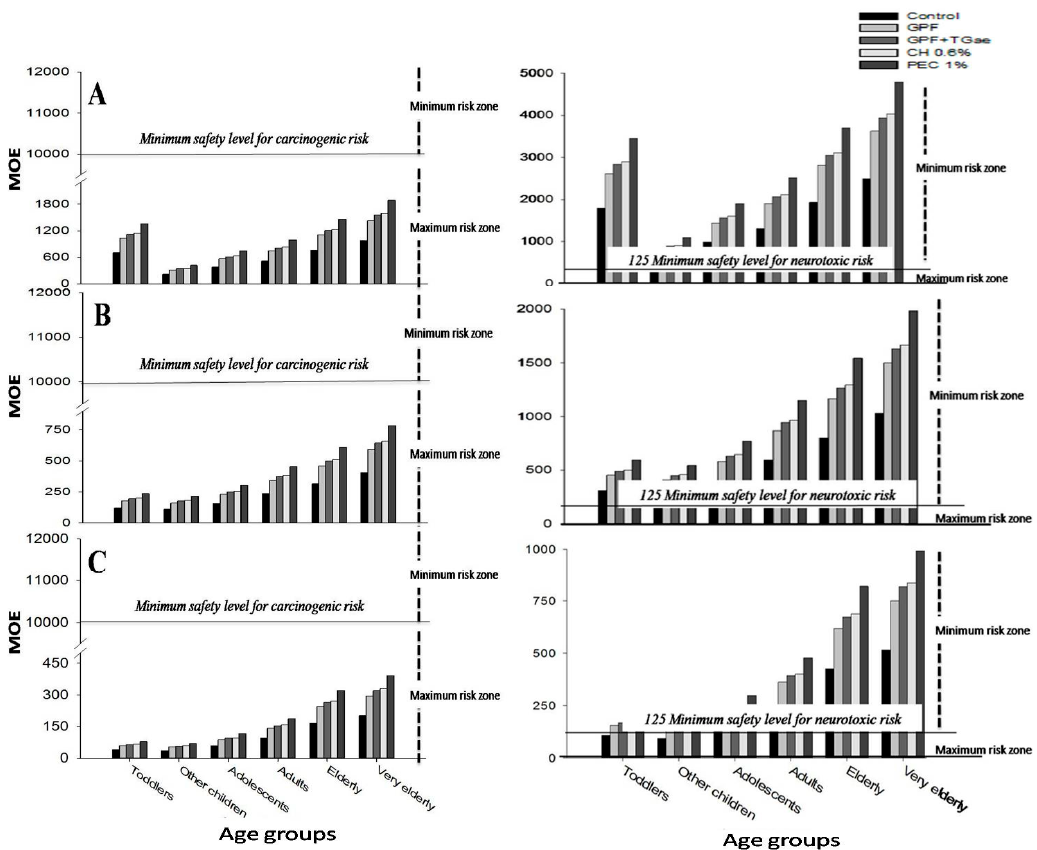
Figure 2. Margin of exposure (MOE) values for carcinogenicity (left panel) and neurotoxic (right panel) of acrylamide through the consumption of French fries that were both uncoated and coated with hydrocolloid coating solutions. Samples were coated with different hydrocolloid-based coatings made of GPF, grass pea flour; GPF + TGase, grass pea flour treated by transglutaminase; PEC, pectin; and CH, chitosan. “Uncoated” represents the control sample dipped in distilled water, across different consumer age groups: ( A ) minimum, ( B ) median, and ( C ) maximum of consumption levels estimated from the 2015 EFSA report. Further experimental details are given in the text.